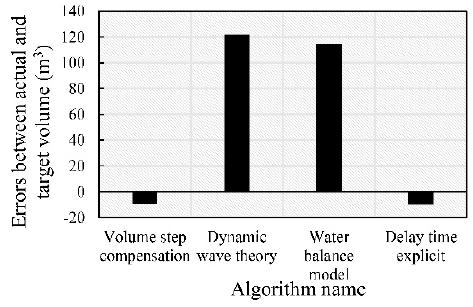
Figure 7. Di ff erences between actual and target storage of canal pool after water Figure 7. Differences between actual and target storage of canal pool after water intake. Table 4. Percentage of actual compensation storage to target compensation storage.